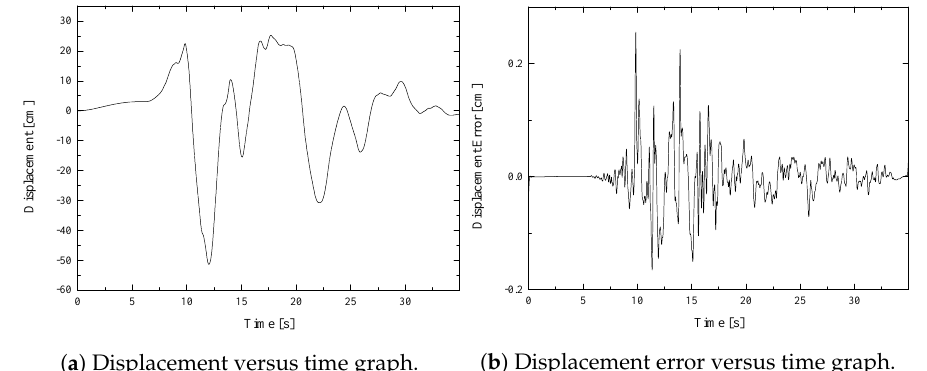
Figure 13. Seismic shake table experimental results for the 1999 Kocaeli earthquake reference seismic